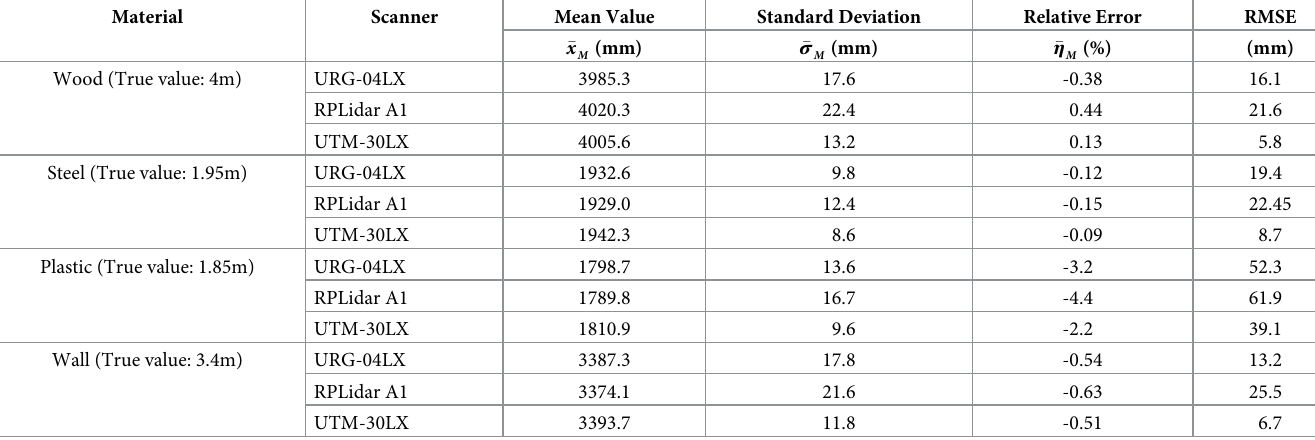
Table 6. Effect of materials on range